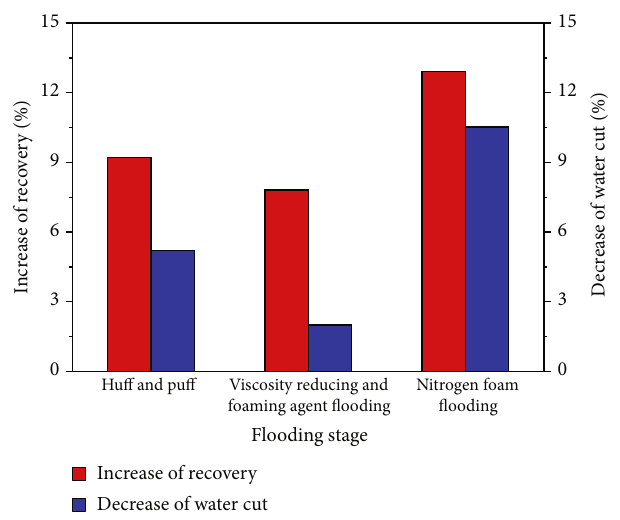
Figure 11: Increase in oil recovery and decrease in water cut at di ff erent core fl ooding